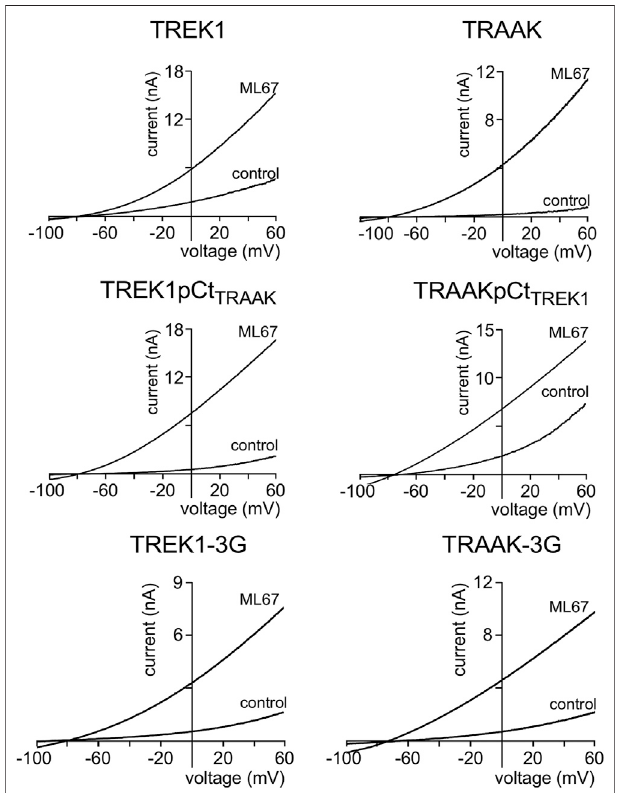
FIGURE2| ProximalC-terdomain(pCt)modulateschannelsensitivityto drugs. Representative patch-clamp recordings from HEK cells expressing the indicated channels in the presence of ML67 (100 μ M). Voltage ramps were applied from − 100 to 60 mV from a holding potential of − 80mV.